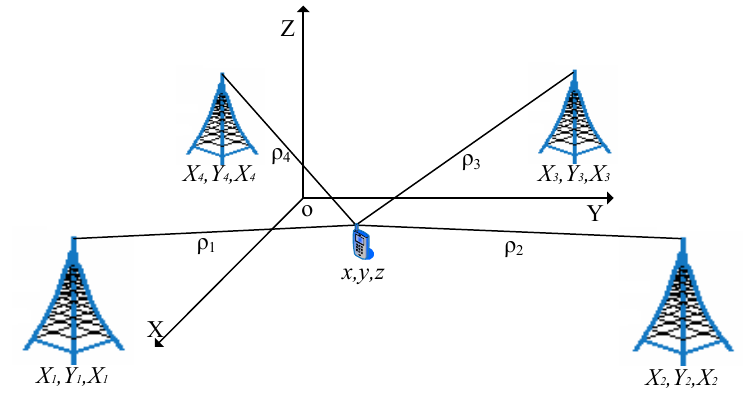
Figure 5. Four BSs joint positioning.